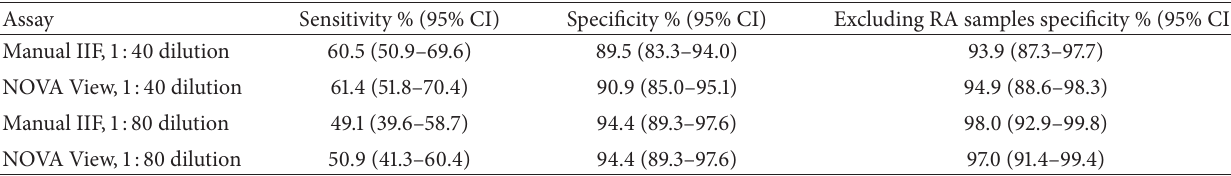
Table 3: Clinical sensitivity and